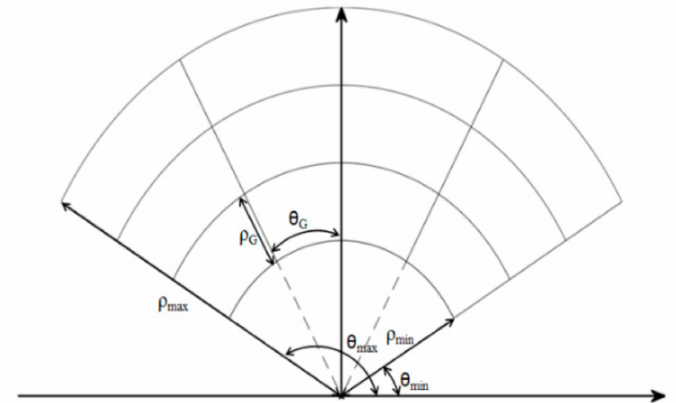
Figure 2. Parameters of polar grid.